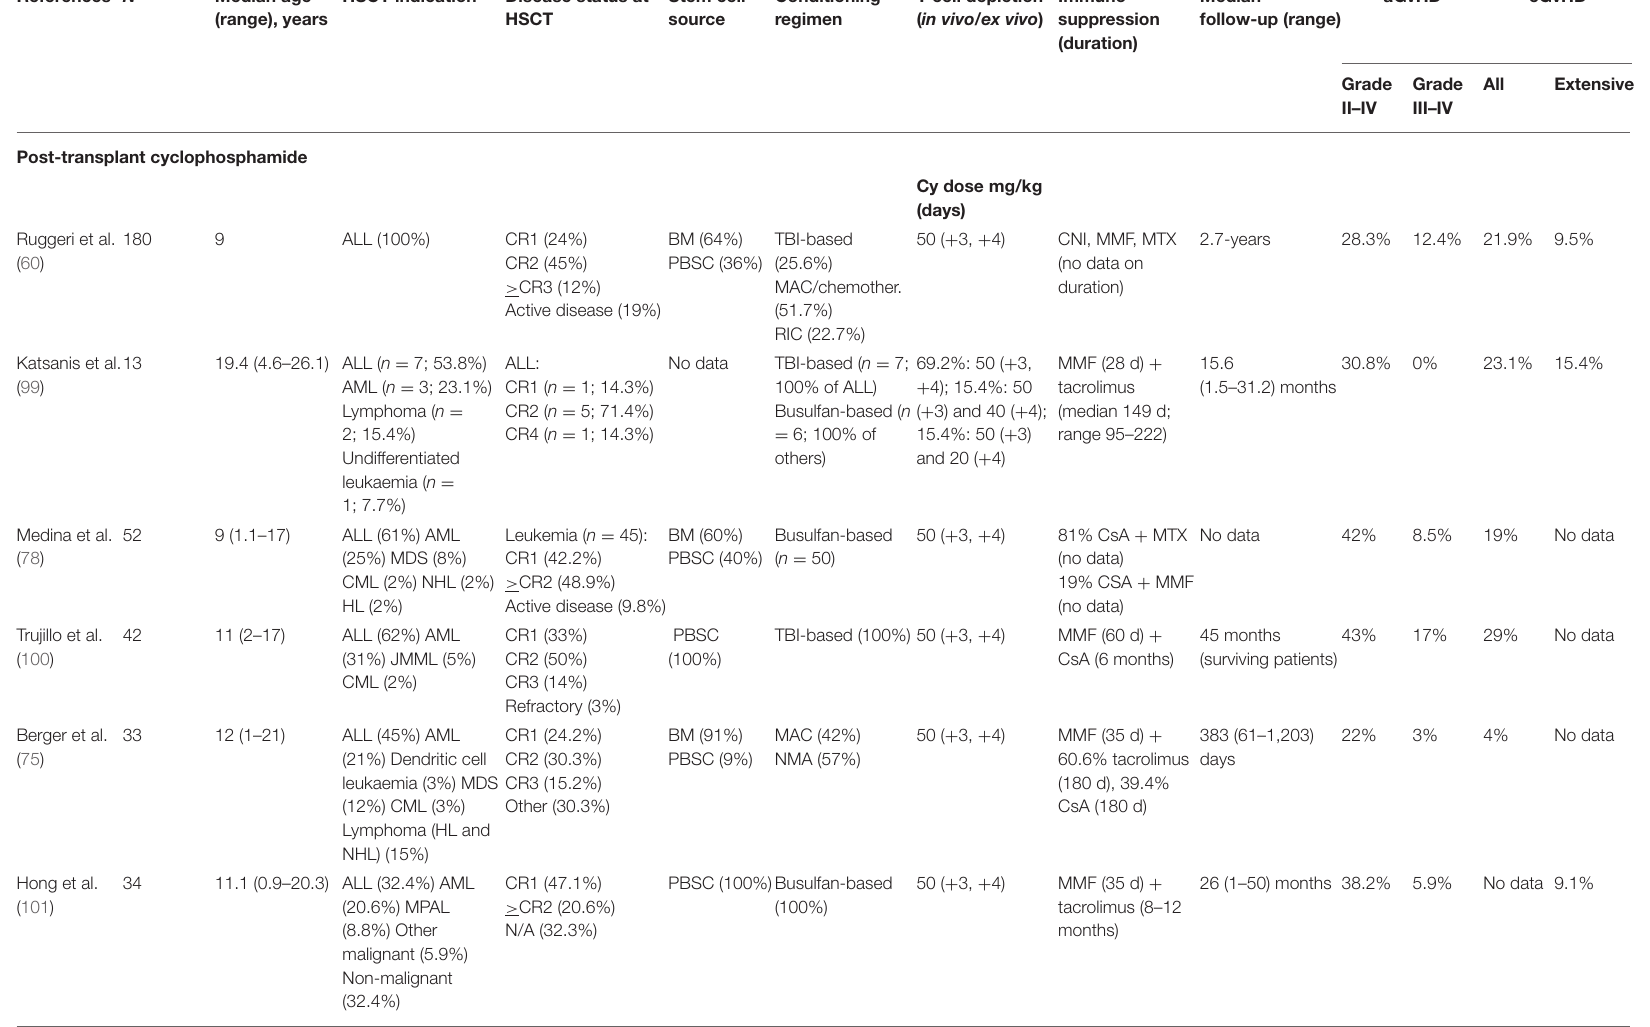
TABLE 2 | Cumulative incidence of GvHD following hHSCT in studies using PTCy, ex vivo TCD or the Beijing